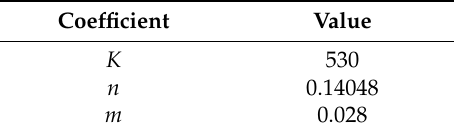
Figure 2. Specimen for quasi-static tensile test. Table 1. Material constants of Al